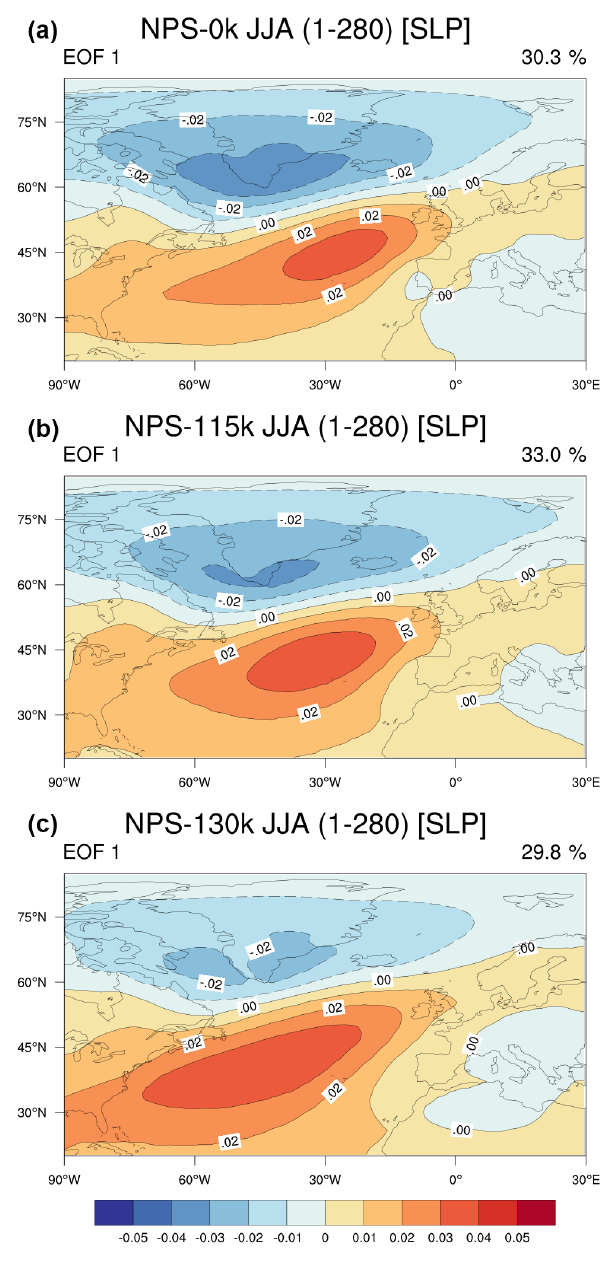
Figure 8. Summertime (JJA) leading EOF of SLP for (a) NPS-0k, (b) NPS-115k and (c) NPS-130k (years 1–280).